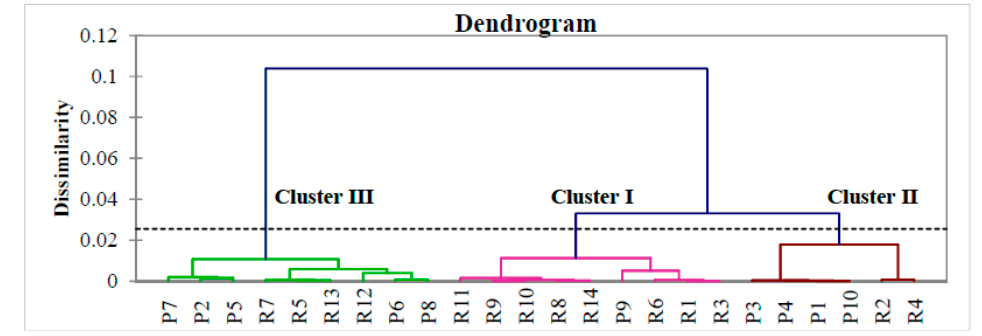
Figure 4. Dendrogram of E. longifolia roots and products.